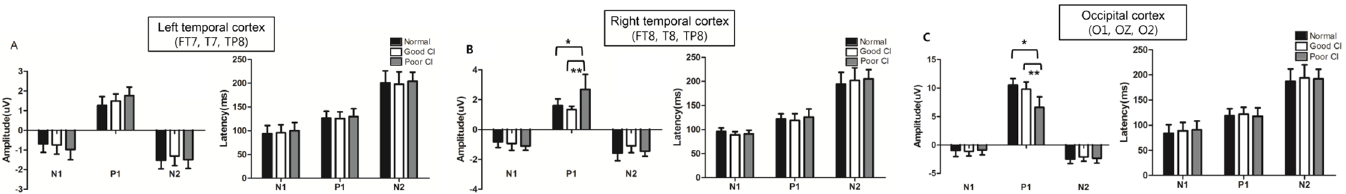
Fig 4. Average amplitudes and latencies of three VEP components from three different locations in the study population. (A) The average amplitude and latency of VEP in left temporal cortex. There was no statistical difference among the three groups (control, good CI performer and poor CI performer) in each peak of amplitude and latency. (B) The average amplitude and latency of VEP in right temporal cortex. P1 amplitude of right temporal cortex in poor CI group was significantly larger than normal control and good CI performer group. ( * ; P = 0.016 and ** ; P = 0.002, Mann-Whitney test) However, the other peak of amplitude and latency was not different among the three groups. (C) The average amplitude and latency of VEP in occipital cortex. P1 amplitude of occipital cortex in poor CI group was significantly smaller than normal controls and good CI performer group. ( * ; P = 0.006 and ** ; P = 0.013, Mann-Whitney test) There was no significance in latency of each peak.